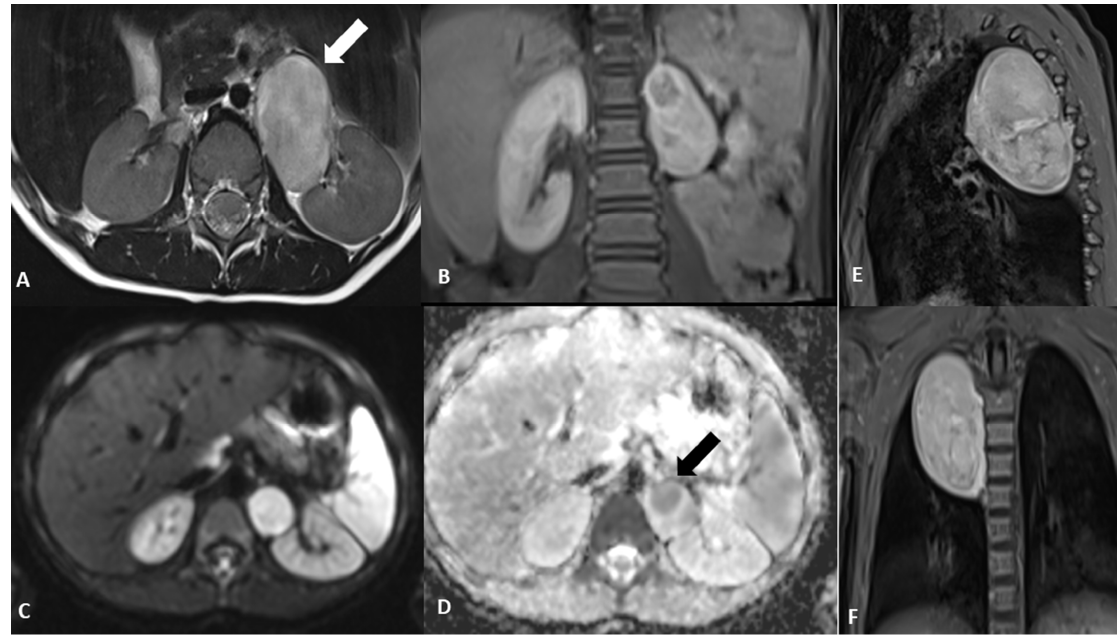
Figure 2. Magnetic resonance imaging (MRI) at baseline. The exam was performed in order to complete the framing and precisely define the anatomic relationships, which confirmed the two clear ‐ edged, capsular, expansive formations located in the posterior mediastinum and in the left anterior paravertebral abdominal site, in the absence of intraspinal extension. An axial T2 ‐ weighted image shows the abdominal paravertebral mass ( A ) that presents inhomogeneous enhancement after contrast administration ( B ). The thoracic lesion in the posterior mediastinum shows a similar perfusion pattern, as shown in the coronal and sagittal T1 ‐ weighted images ( E , F ). ( C ) MRI axial diffusion ‐ weighted imaging (DWI) shows a hyperintense rounded area with low apparent diffusion coefficient (ADC) value in the upper portion of the abdominal mass, as shown in D (arrow). Blood tests and urinary catecholamines were within normal limits. In order to determine a diagnosis of certainty, an echo ‐ guided biopsy of the lesion located at the level of the posterior mediastinum was performed, as it was more easily reached than the abdominal mass; histopathological features were finally consistent with a GNBI, with the presence of Schwannian stromal development occupying >50% of tumor tissue [1] (see also histological image).